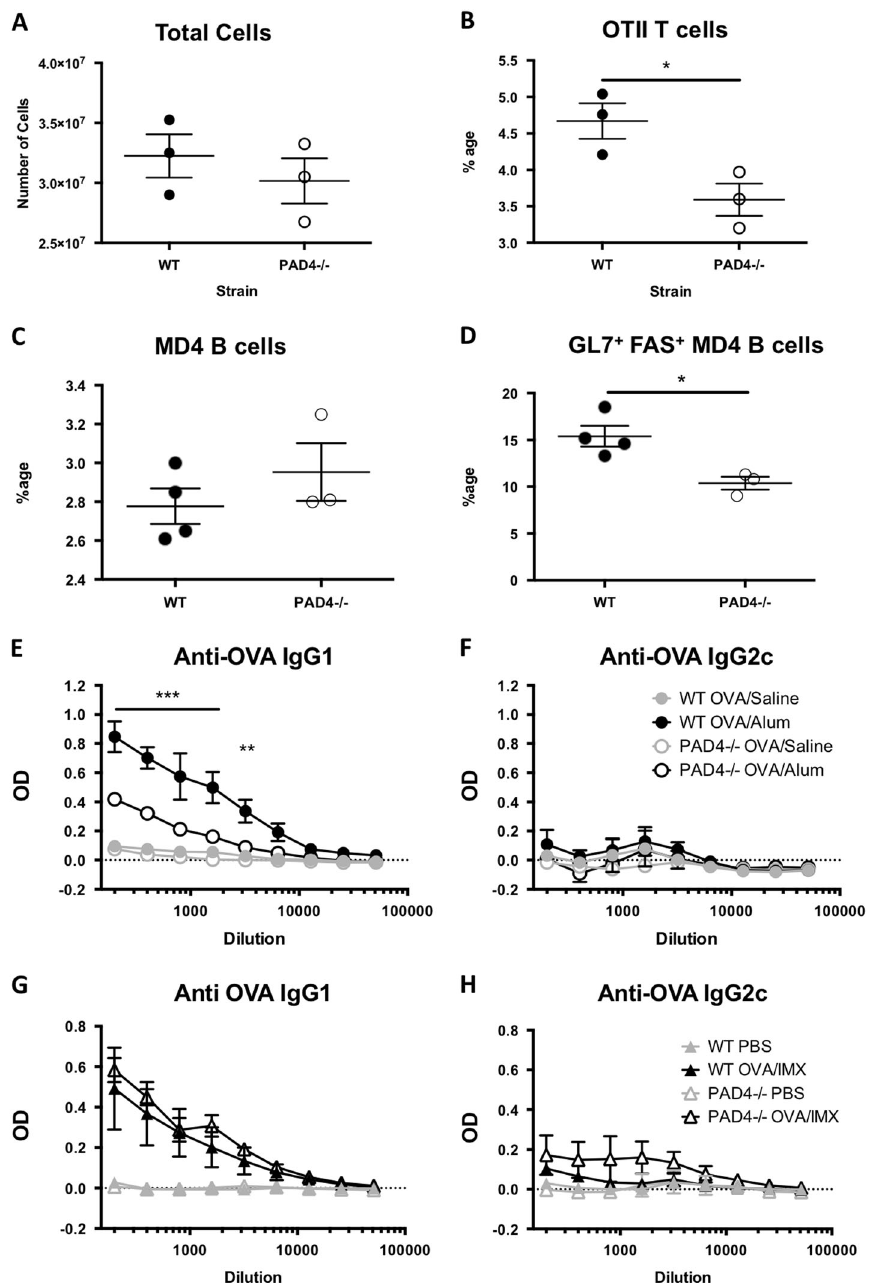
Fig. 5 Deletion of PAD4 affects the magnitude of the adaptive immune response induced by alum adjuvant. Antigen-speci fi c T (OTII) and B cells (MD4) were adoptively transfered to PAD4ko and WT mice. a Five days after immunisation, PAD4ko mice had similar numbers of cells in dLNs; b however, the proportion of antigen-speci fi c OTII T cells was signi fi cantly lower in PAD4ko compared with WT mice (* P < 0.05). c Analysis of antigen-speci fi c B cells on day 7 after immunisation revealed a similar proportion of the B-cell population in PAD4ko mice were IgMa+ HEL-speci fi c; d however, the fewer GL7 + FAS + germinal centre B cells were observed (* P < 0.05) compared with WT control mice. e PAD4KO mice immunised with OVA/Alum show reduced OVA-speci fi c IgG 1 titres compared with WT littermates 14 days after immunisation. f Levels of antigen-speci fi c IgG 2c antibodies are undetectable in both strains of mouse. g , h Antigen-speci fi c IgG 1 and IgG 2a responses were similar in WT and PAD4KO mice 14 days after immunisation with OVA/ISCOMATRIX. Levels of antigen-speci fi c IgG 2c antibodies are undetectable in both strains of mouse. Antibody analysis was performed on two to four mice per group, and data are representative of two to three experiments. *P < 0.05, ** P < 0.01, *** P <